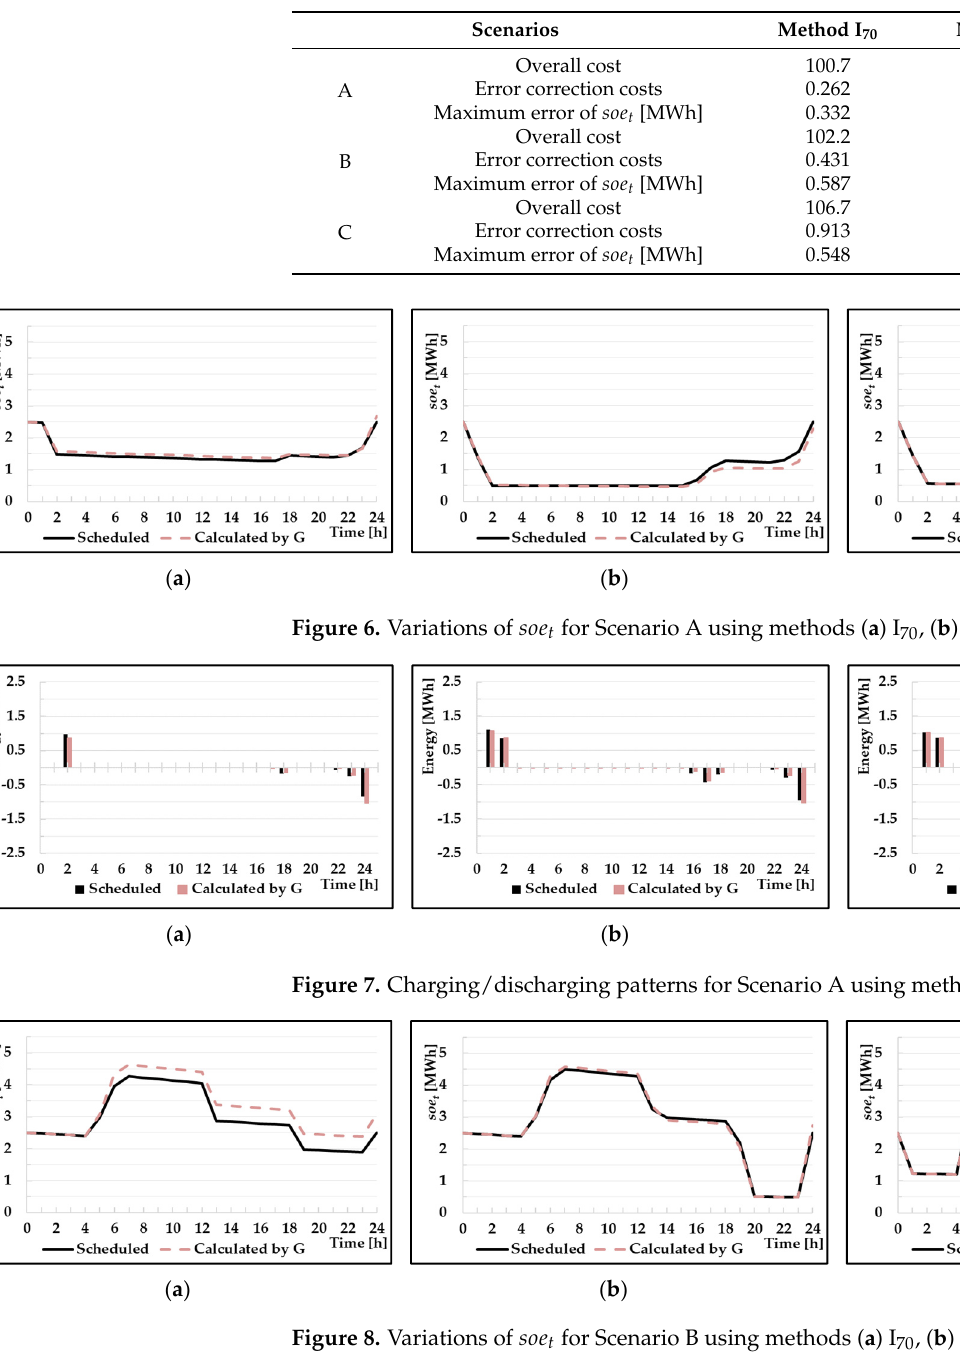
Table 4. Overall cost and maximum Error in soe t comparison of the three methods presented herein during one day.